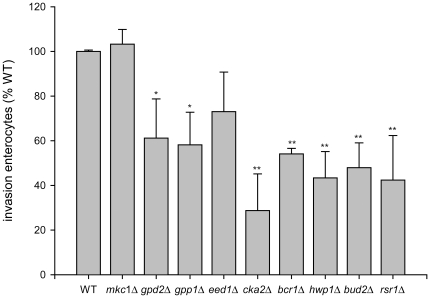
Enterocyte invasion by group 4 and 5 damage-associated
mutants.
C. albicans cells (wild type and
rsr1Δ, bud2Δ,
hwp1Δ, bcr1Δ,
cka2Δ, eed1Δ,
gpp1Δ, gpd2Δ and
mkc1Δ) were co-incubated with Caco-2
enterocytes for 3 h. After fixation the samples were differentially
stained and analyzed under the fluorescence microscope. The experiment
was performed at least three times in duplicates. */**,
significant difference compared to the corresponding WT invasion
(control) (p<0.05/p<0.01).